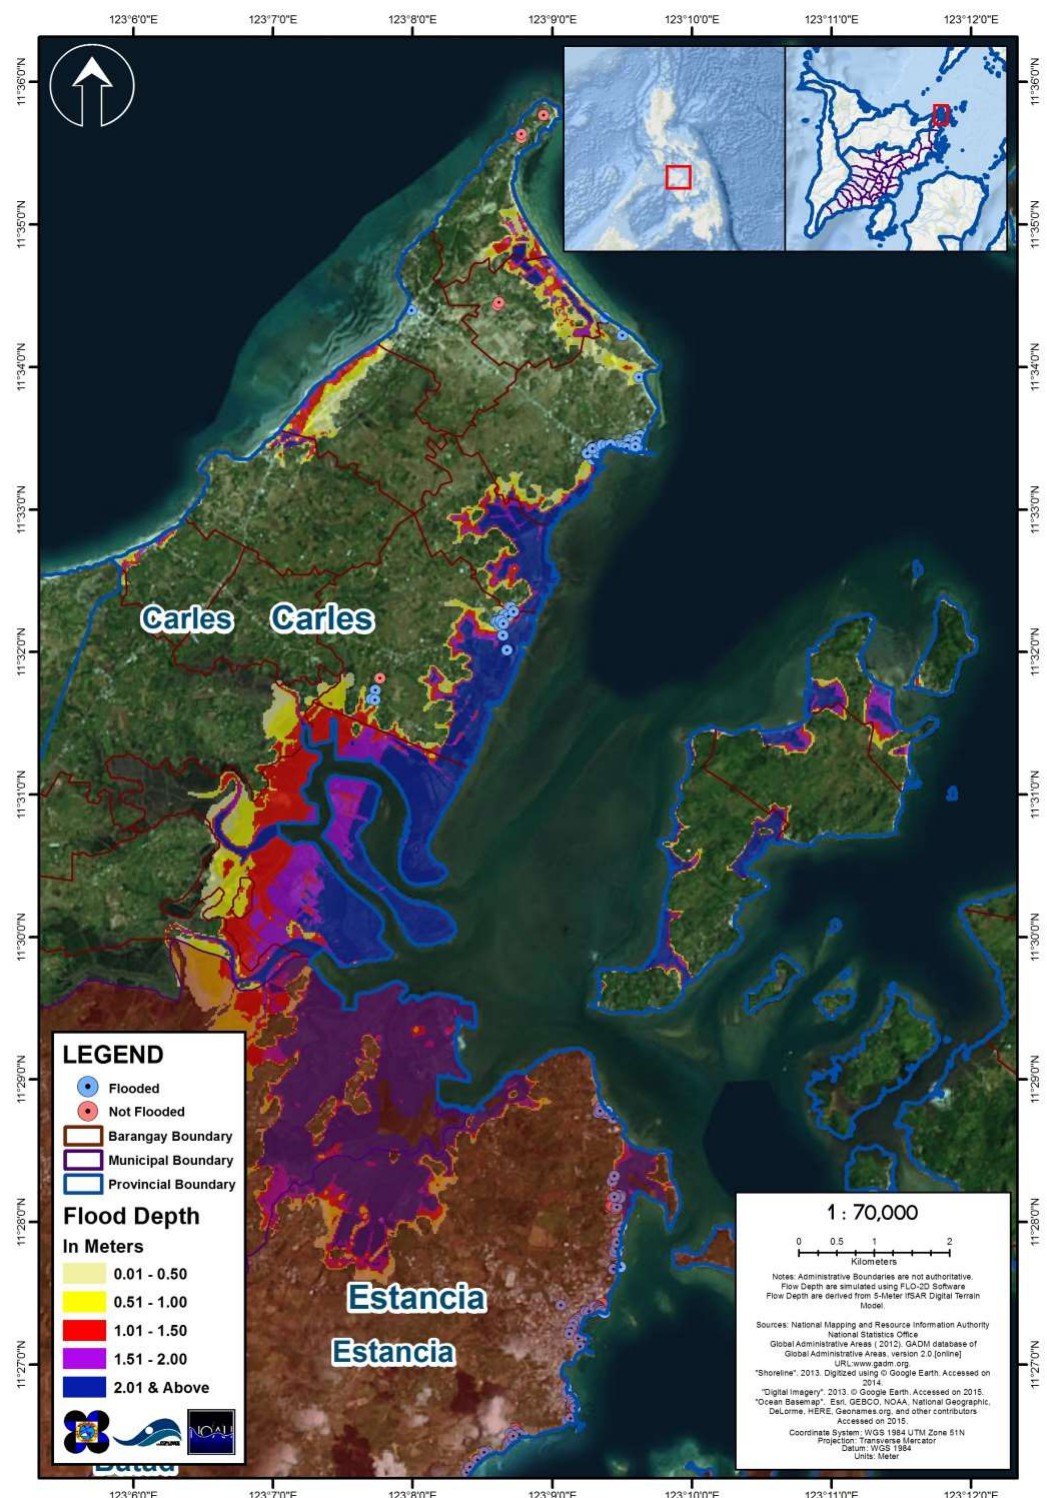
Figure 6. Storm surge inundation and validation points of Carles, Iloilo. Validation points: blue circle (observed flooding) and red circle (no flooding).